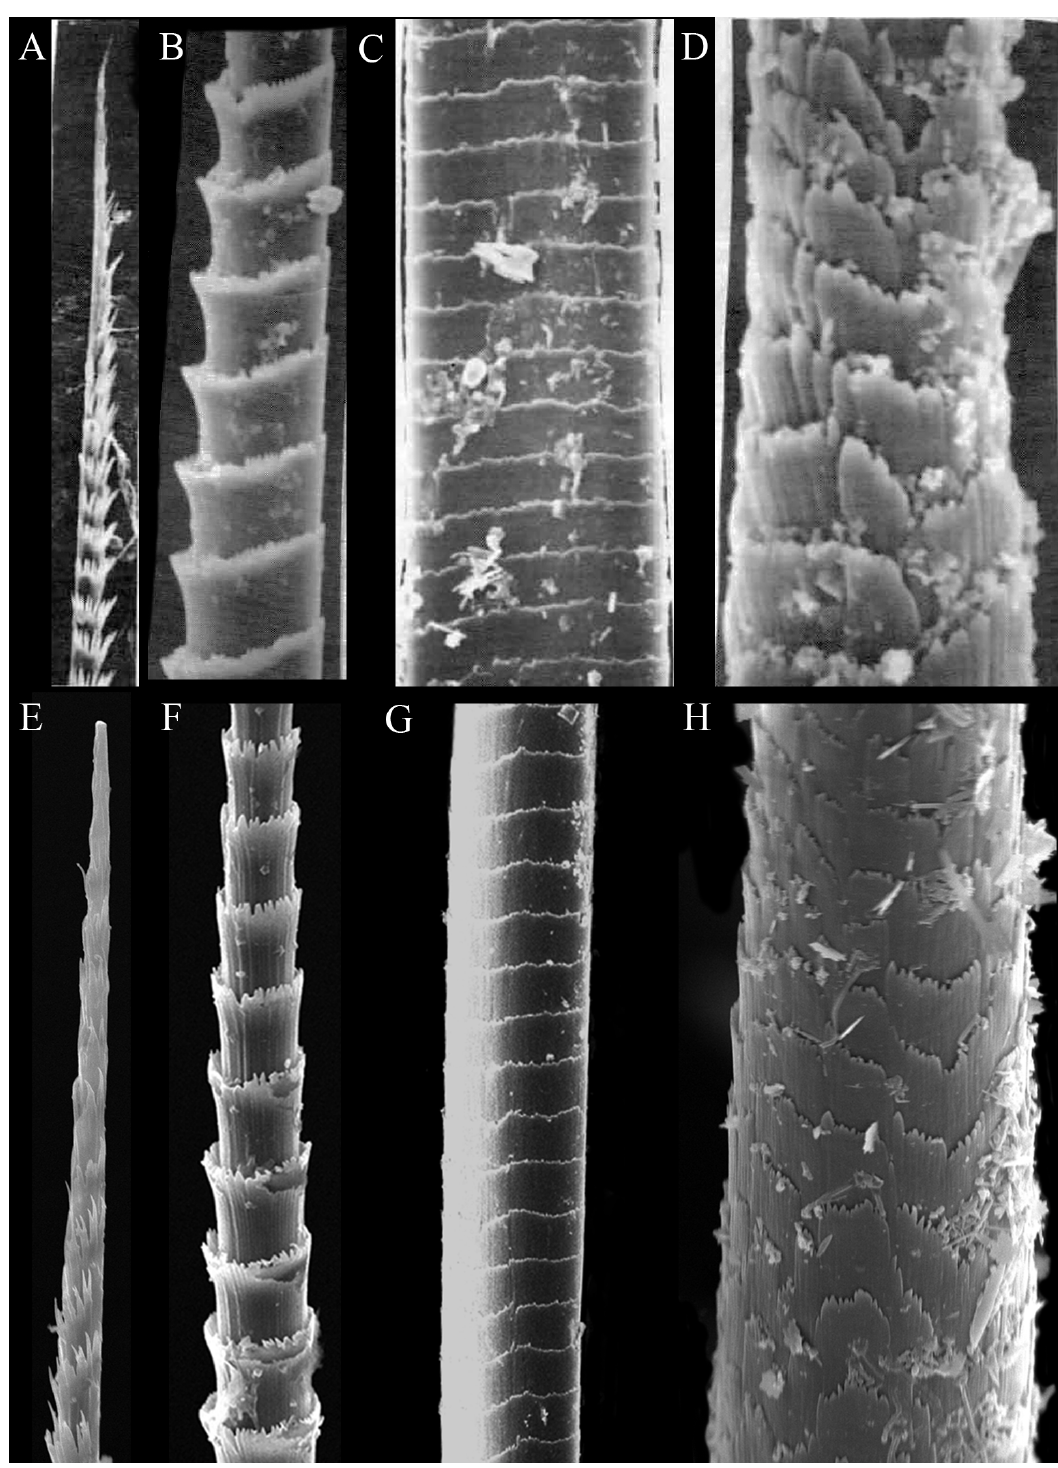
Fig. 12. Comparation between opercular paleae of Phalacrostemma dorothyae Kirtley, 1994. A–D . Holotype of P. dorothyae . A . Tip of outer palea. B . Middle region of outer palea. C . Proximal region of outer palea. D . Thecae of inner palea. E–H . P. dorothyae , this work (UMML-22.1184). E . Tip of outer palea. F . Middle region of outer palea. G . Proximal region of outer paleae. H . Thecae of inner palea. A–D, modified from Kirtley